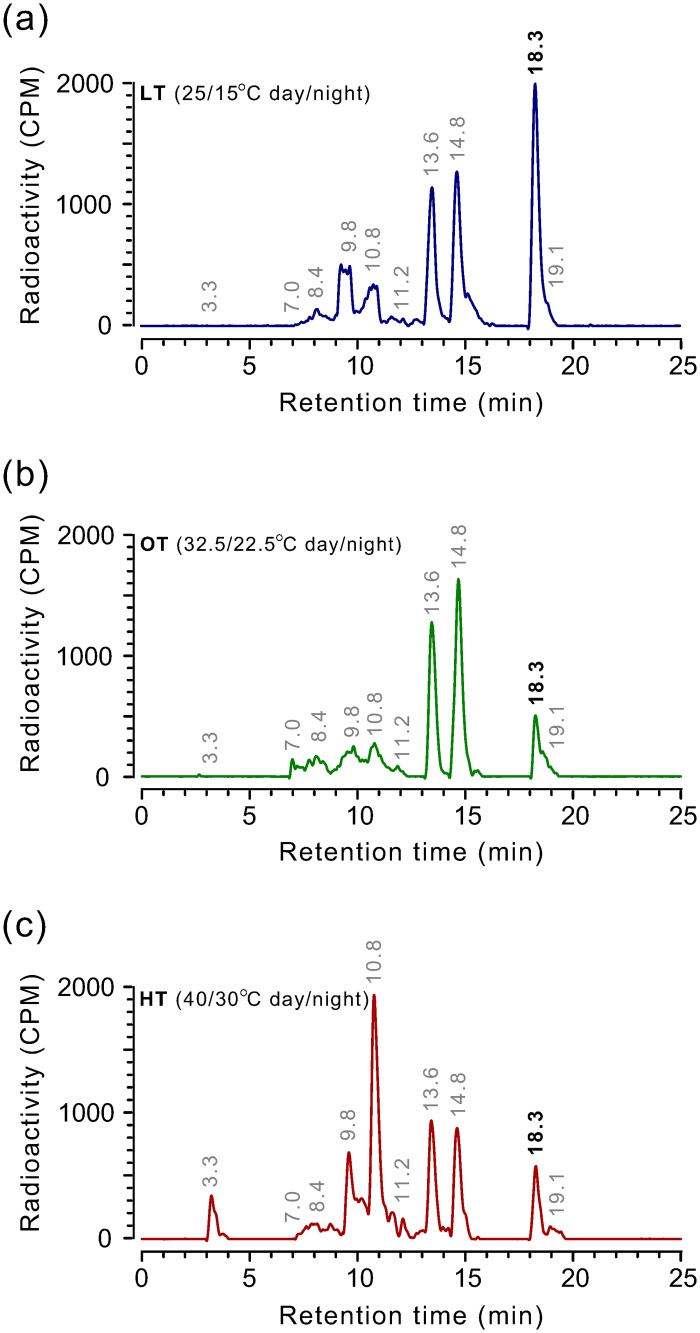
Representative reverse-phase HPLC chromatograms of mesotrione metabolism in Palmer amaranth plants grown under (a) LT (25/15°C day/night), (b) OT (32.5/22.5°C day/night, and (c) HT (40/30°C day/night) conditions (15/9 h day/night) at 48 h after treatment.Peak retention time around 18.3 min represents the parent mesotrione compound. Palmer amaranth plants (10 to 12 cm tall) were treated with 8- x 2.5-μL droplets (1.6548 mM mesotrione, 0.85% w/v AMS, and 1% COC) containing 7.2 kBq of [14C] mesotrione on the upper surface of fourth and fifth youngest leaves. Numbers above the peaks represent retention time (min).